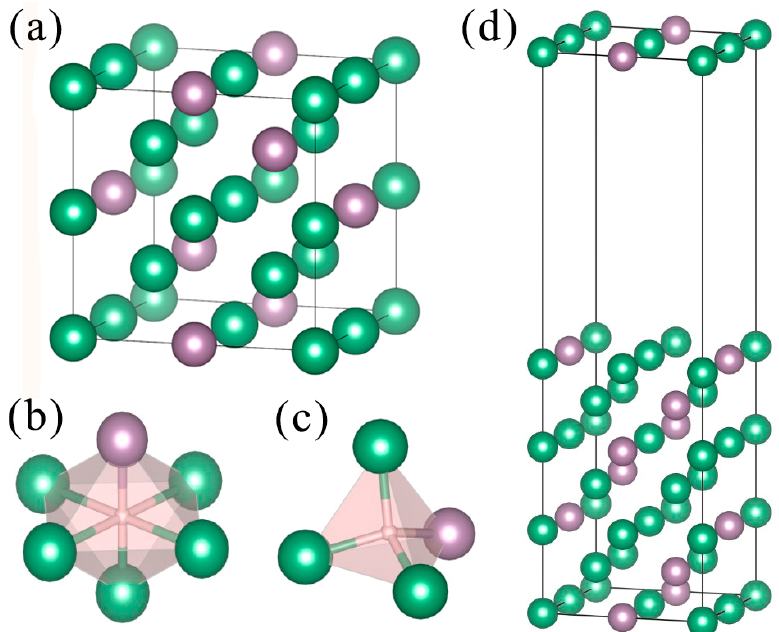
Figure 1. Theoretical models of Nb 12 Mo 4 used in the calculations: ( a ) bulk model; ( b ) an octahedral interstitial site (OIS), ( c ) a tetrahedral interstitial site (TIS); ( d ) slab model. Nb atoms are represented by green spheres, and Mo atoms are represented by gray spheres.